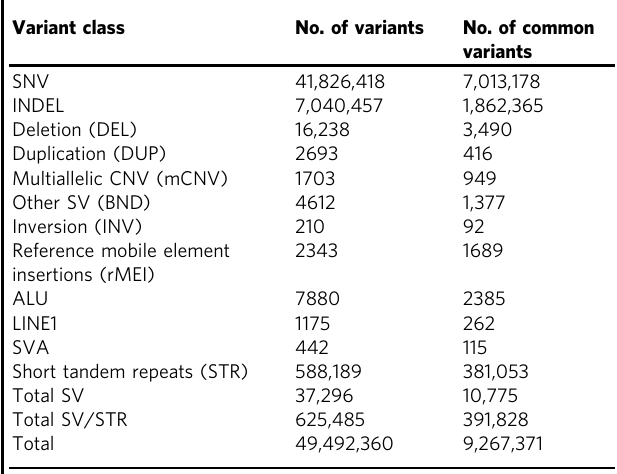
Table 1 Summary of i2QTL variants called from samples in the HipSci and iPSCORE